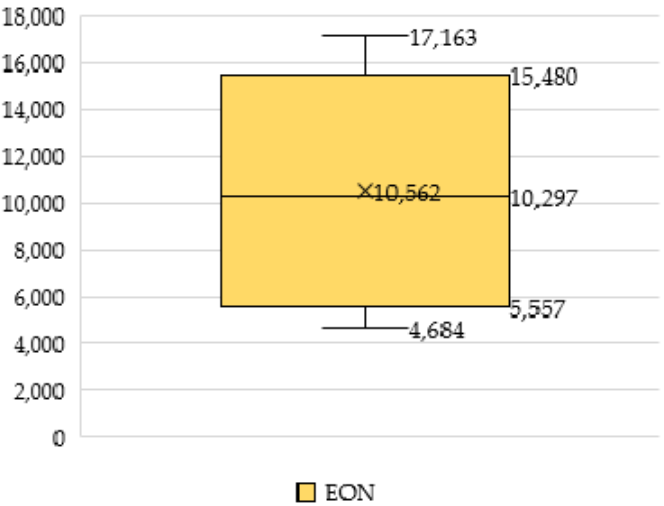
Figure 4. Total energy for the diesel oil consumed [MJ · ha − 1 ]. Source: own study.